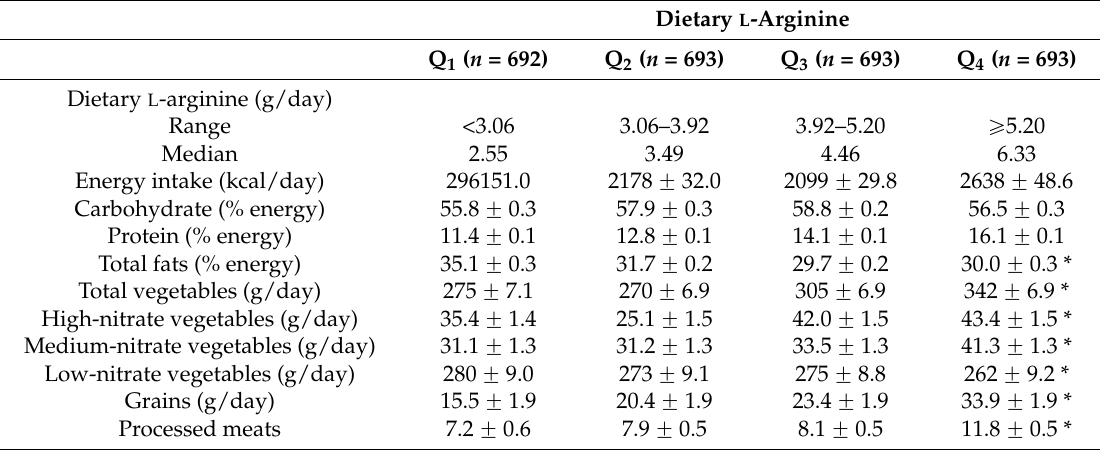
Table 2. Dietary intakes of the participants across quartiles of L -arginine intakes.